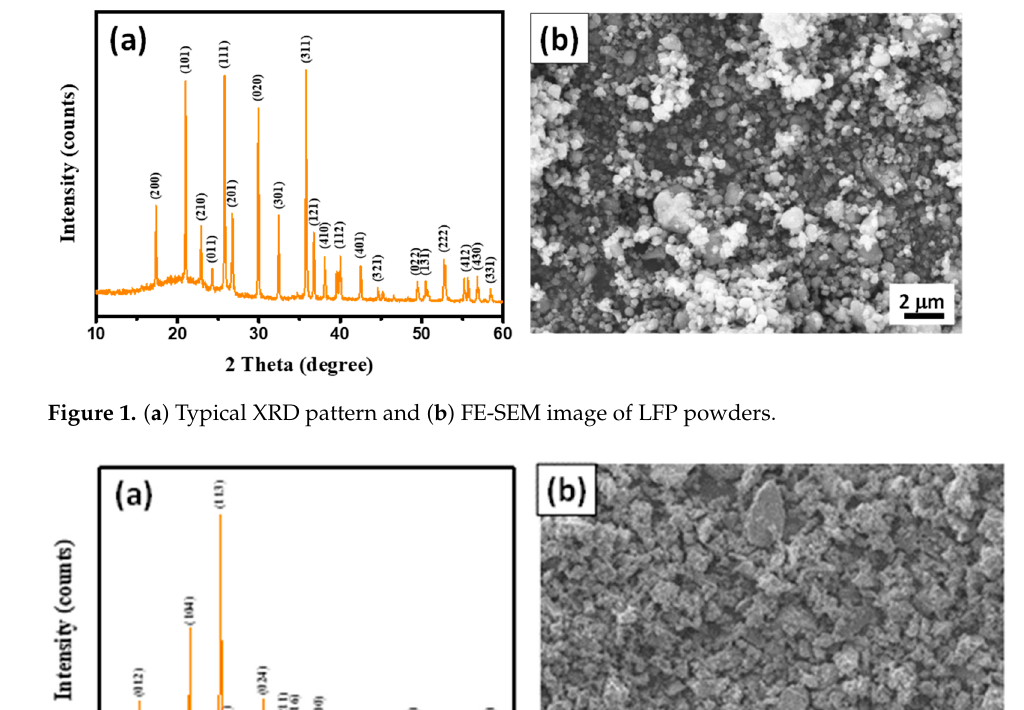
Figure 2. ( a ) Typical XRD pattern and ( b ) FE-SEM image of LATP powders. Th e t ypical XRD pattern of CSEs (i.e., composition: LATP plus LiTFSI plus PVDF-